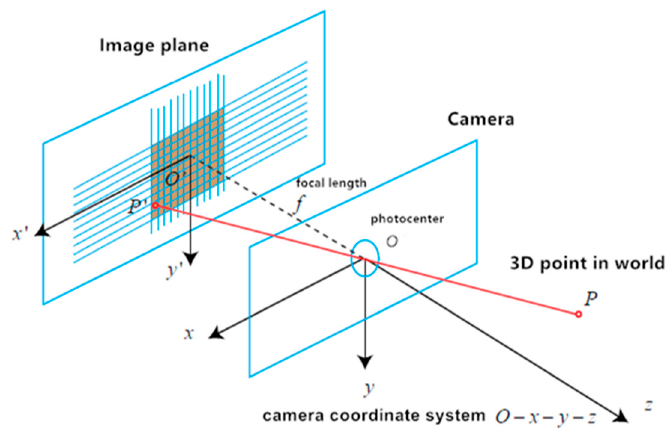
Figure 2. Pinhole camera model.